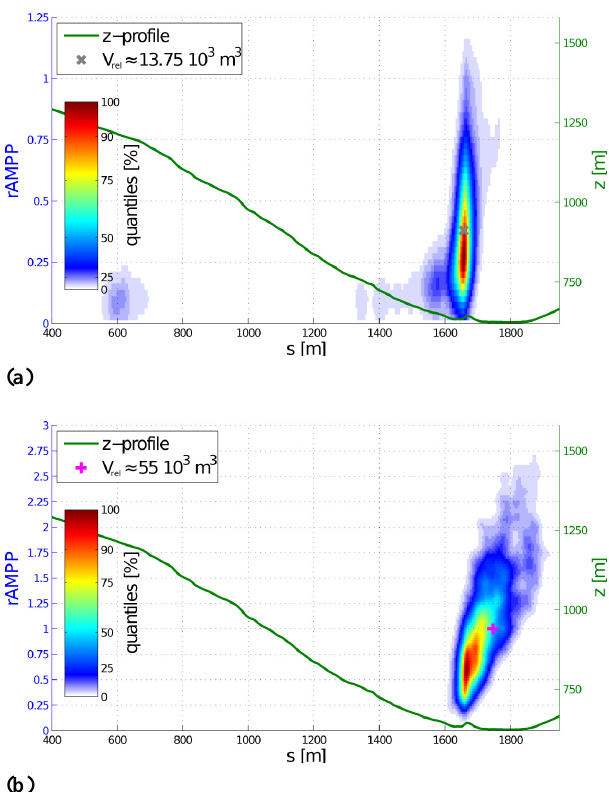
Fig. 6. AIMEC results of the J = 1000 Monte Carlo simulation runs with release volumes V rel ≈ 13 . 75 × 10 3 m 3 (a) and 55 × 10 3 m 3 (b) . Shown is the result density, which increases from blue to red, the quantiles are marked at the colour bar. The reference simula- tion with standard parameters is marked in each case (gray X and pink +